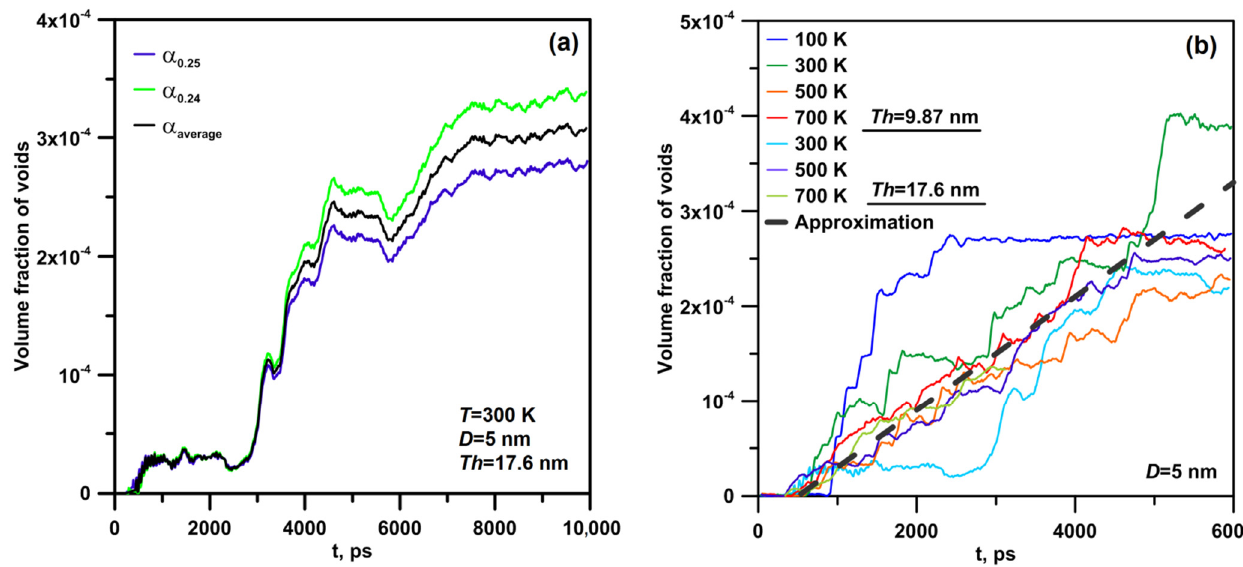
Figure 9. Volume fraction α of voids by dependence on time: ( a ) for a single system with two different radii of probe sphere of “Construct surface mesh” algorithm; and ( b ) for different systems with additional linear approximation.